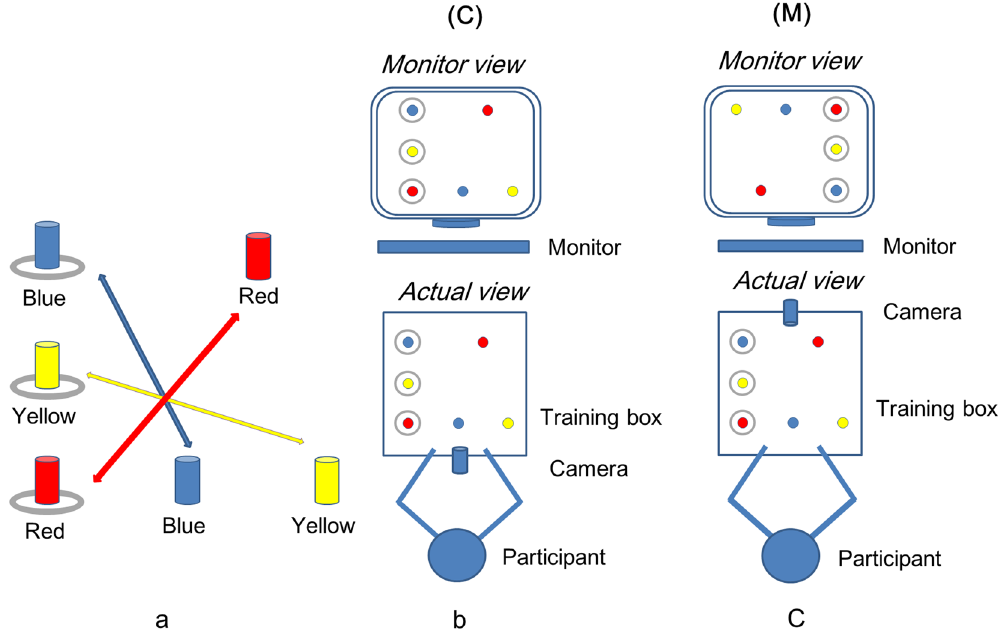
Figure 3. Setup of the training box. ( a ) Modified peg transfer task: There are three pegs in blue, yellow, and red, on the left side of the pegboard in a straight line and three other pegs in corresponding colors on the right side of the pegboard in a triangle. Using laparoscopic forceps, the participants moved three ring shaped objects from the left side to the right side while matching colors, and moved the three ring shaped objects back from the right side to left side while matching colors. ( b ) Coaxial image (C): the camera faced the target in the direction of the participant’s line of sight and the monitor was in front of the participant. The angle of the view on the monitor was the same as the actual view. ( c ) Mirror image (M): the camera was placed on the opposite side of the participant. The difference in angle between the actual view and the view on the monitor was 180